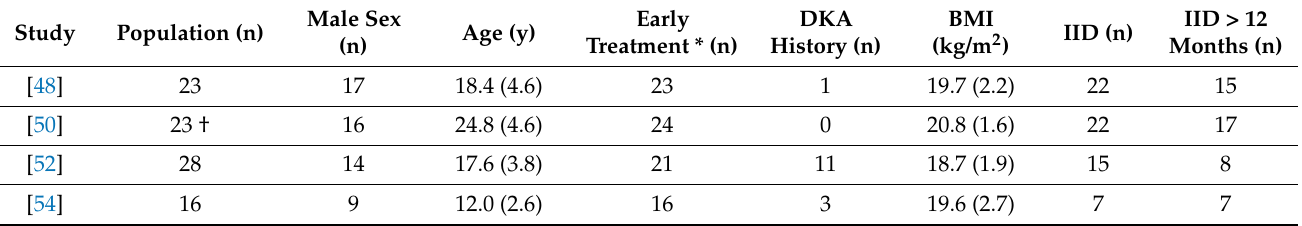
Table 2. Characteristics of patients enrolled in the clinical trials selected for statistical